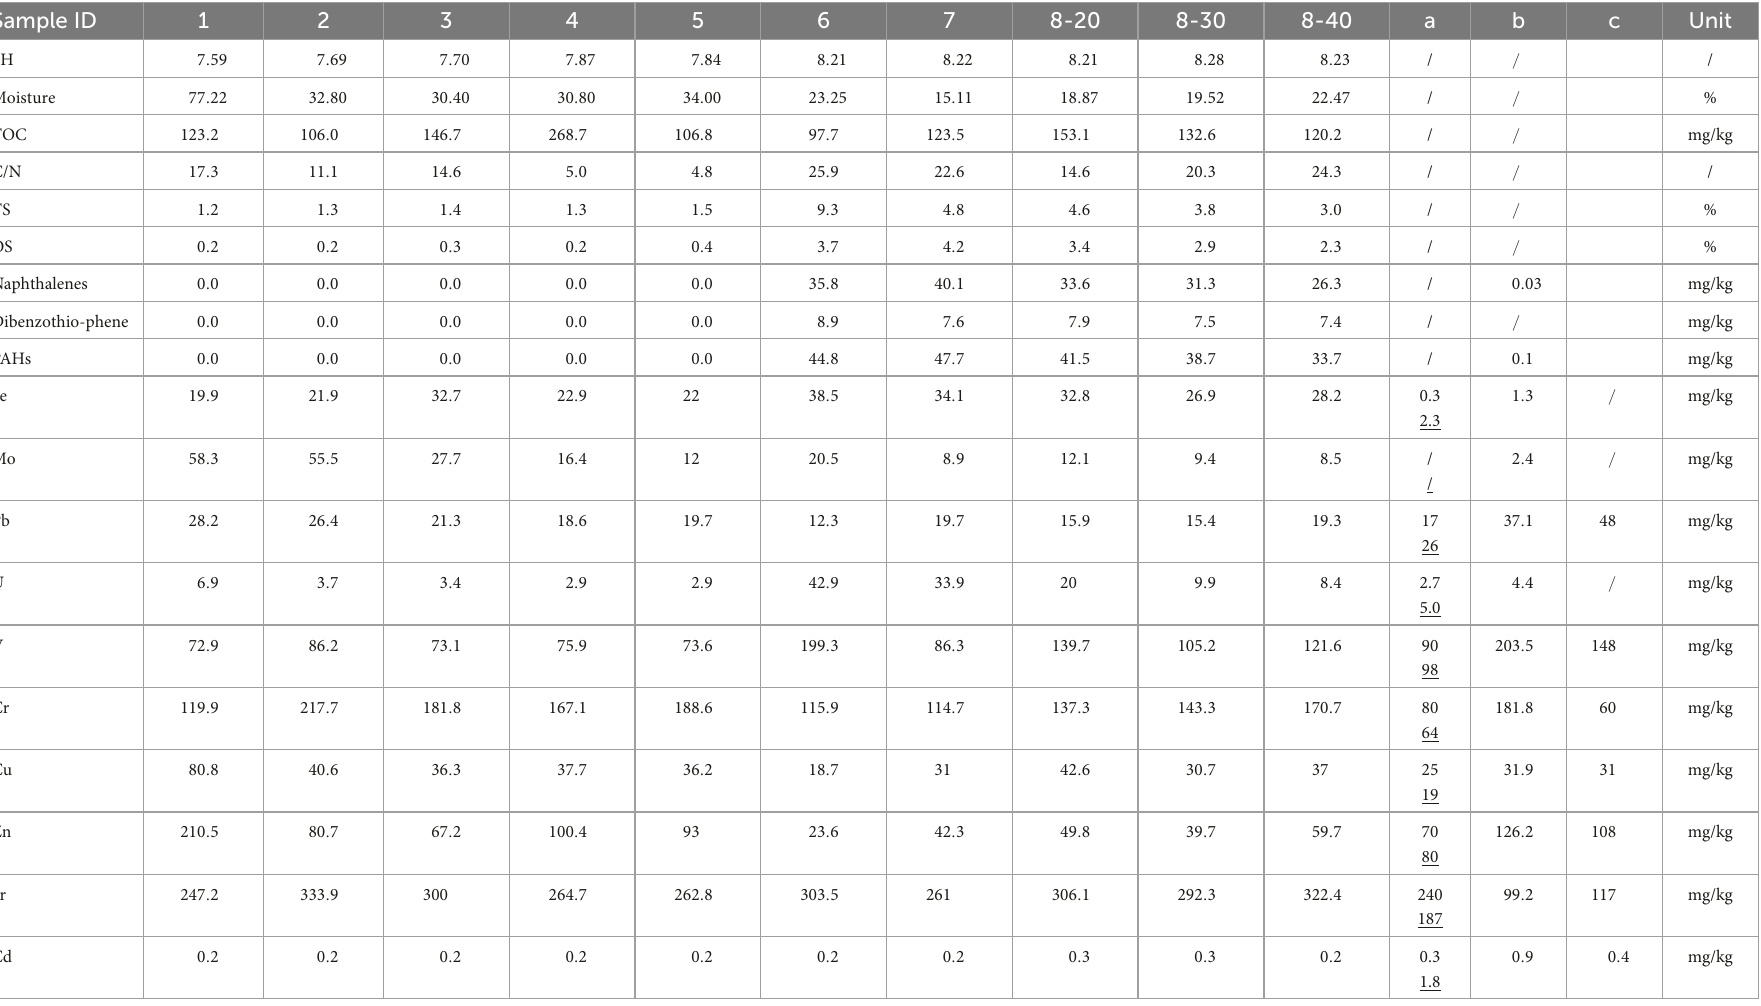
TABLE 1 Physiochemical characteristics, concentrations of toxic organic pollutants and hazardous trace elements of